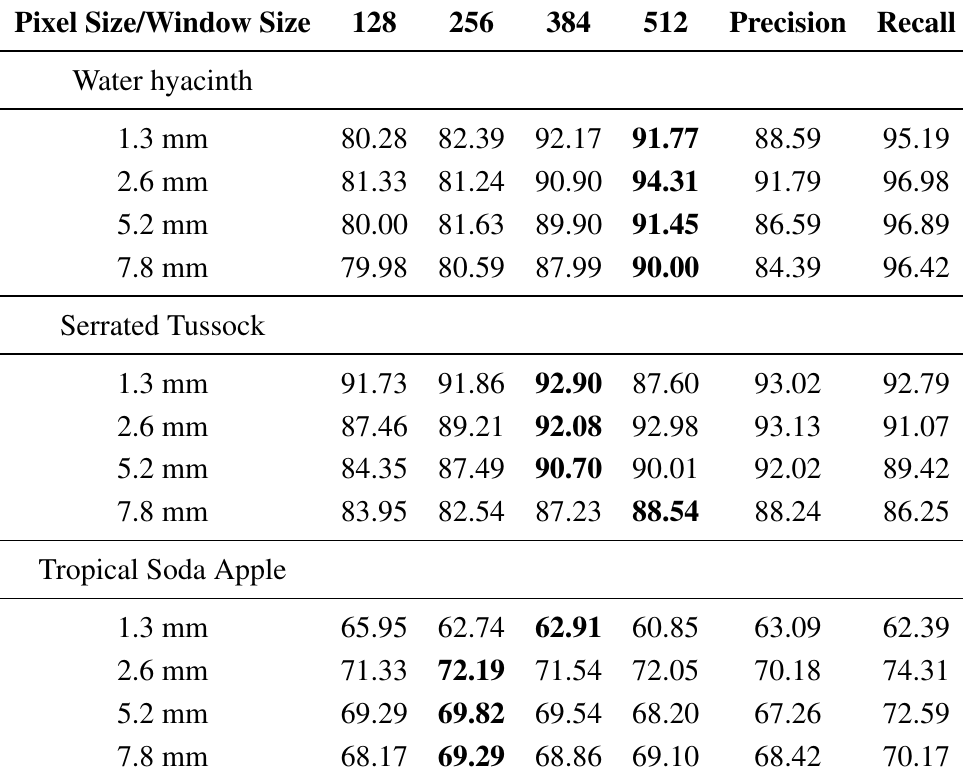
Table 4. Quantitative results: classification performance at different window pixel sizes for each weed species. The precision and recall values for the best window size setting are also shown. These results show that window size is more important than altitude in determining classifier performance for water hyacinth, while both window size and altitude were important for serrated tussock and tropical soda apple.